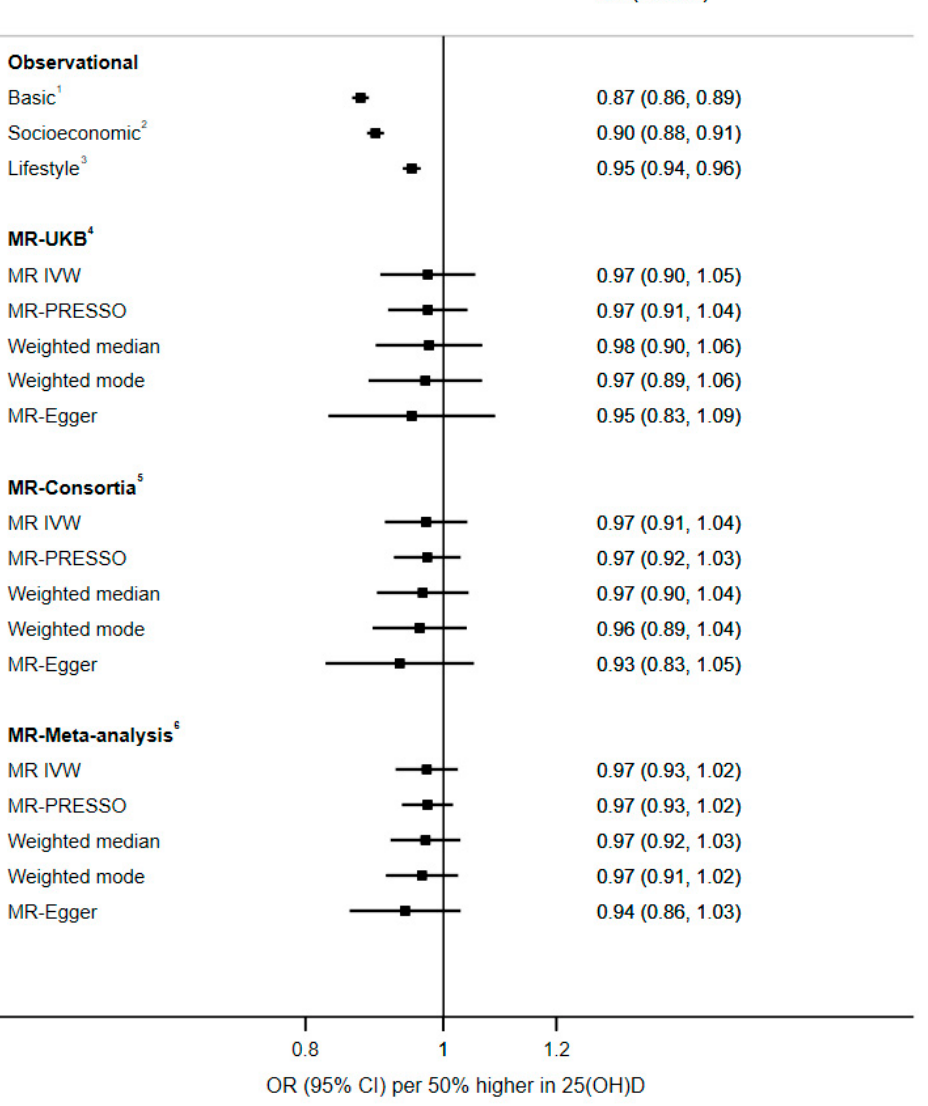
Figure 2. Observational and MR analyses on the association between 25(OH)D and the odds of depression. 1 Basic model included adjustment for basic covariates including age, sex, assessment centre and date of blood sample collected. 2 Socioeconomic model included adjustment for basic and socioeconomic-related covariates including education, Townsend deprivation index and employment. 3 Lifestyle model included adjustment for basic, socioeconomic and lifestyle-related covariates including smoking, alcohol consumption, BMI, physical activity, fish and cheese consumptions, dietary restriction, sun exposure [in summer or winter], use of sun protection, and long-standing illness. 4 MR analysis based on variant-depression association estimates from UK Biobank. 5 MR-analysis based on variant-depression association estimates from Wray et al. GWAS. 6 Meta-analysis of MR estimates from UK Biobank and Wray et al. GWAS. For all MR analysis, variant-25(OH)D estimates were from Jiang et al. GWAS. MR-Egger P-intercept (for all), p < 0.67. The observational analyses indicated that depression was associated with lower 25(OH)D concentrations ( − 1.96%, 95%CI − 2.50 to − 1.42; Figure 3). In MR IVW using 44 MDD-related variants from Wray et al. GWAS (Figure S4), serum 25(OH)D concentrations